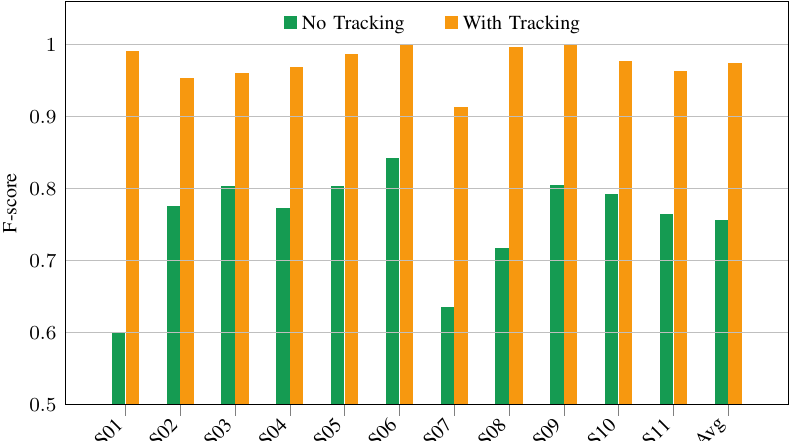
Figure 7. Impact of Tracking on Recall of Face Recognition. Fig. 2. Impact of Tracking on Recall of the Proposed Framework.